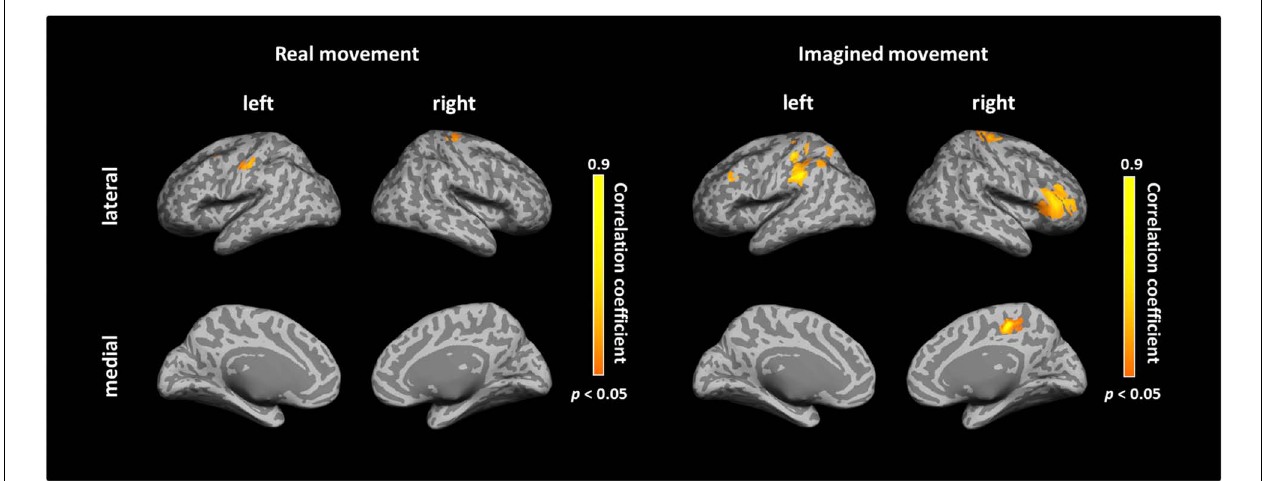
FIGURE 4 | Spatial distributions of significant correlations between decoding accuracy and connectivity during real and imagined movements. Correlation coefficients between decoding accuracy and